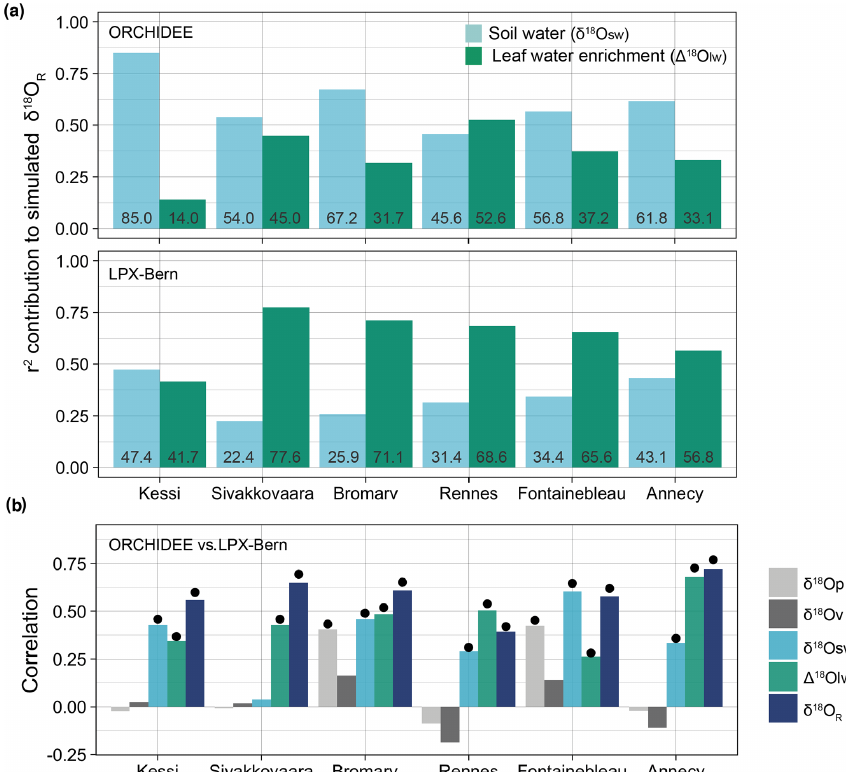
Figure 3. Drivers of simulated δ 18 O R variability and consistency between isotopic forcings and simulations of ORCHIDEE and LPX-Bern across the climate gradient from boreal Finland (left) to temperate France (right). (a) Simulated contributions of source water ( δ 18 O sw ; turquoise) and leaf water enrichment ( (cid:49) 18 O lw ; green) signals to δ 18 O R variability during 1960–2000. The percentage of explained variance ( r 2 ) is indicated in each bar. (b) Correlation between the isotopic composition of precipitation ( δ 18 O p ; light gray) and air vapor ( δ 18 O v ; dark gray) used to force the models and the resulting δ 18 O sw (turquoise), (cid:49) 18 O lw (green), and δ 18 O R (dark blue) simulated by ORCHIDEE and LPX-Bern during 1960–2000. All variables were averaged over the period May–August. Significance at the 95% confidence level is indicated by the black